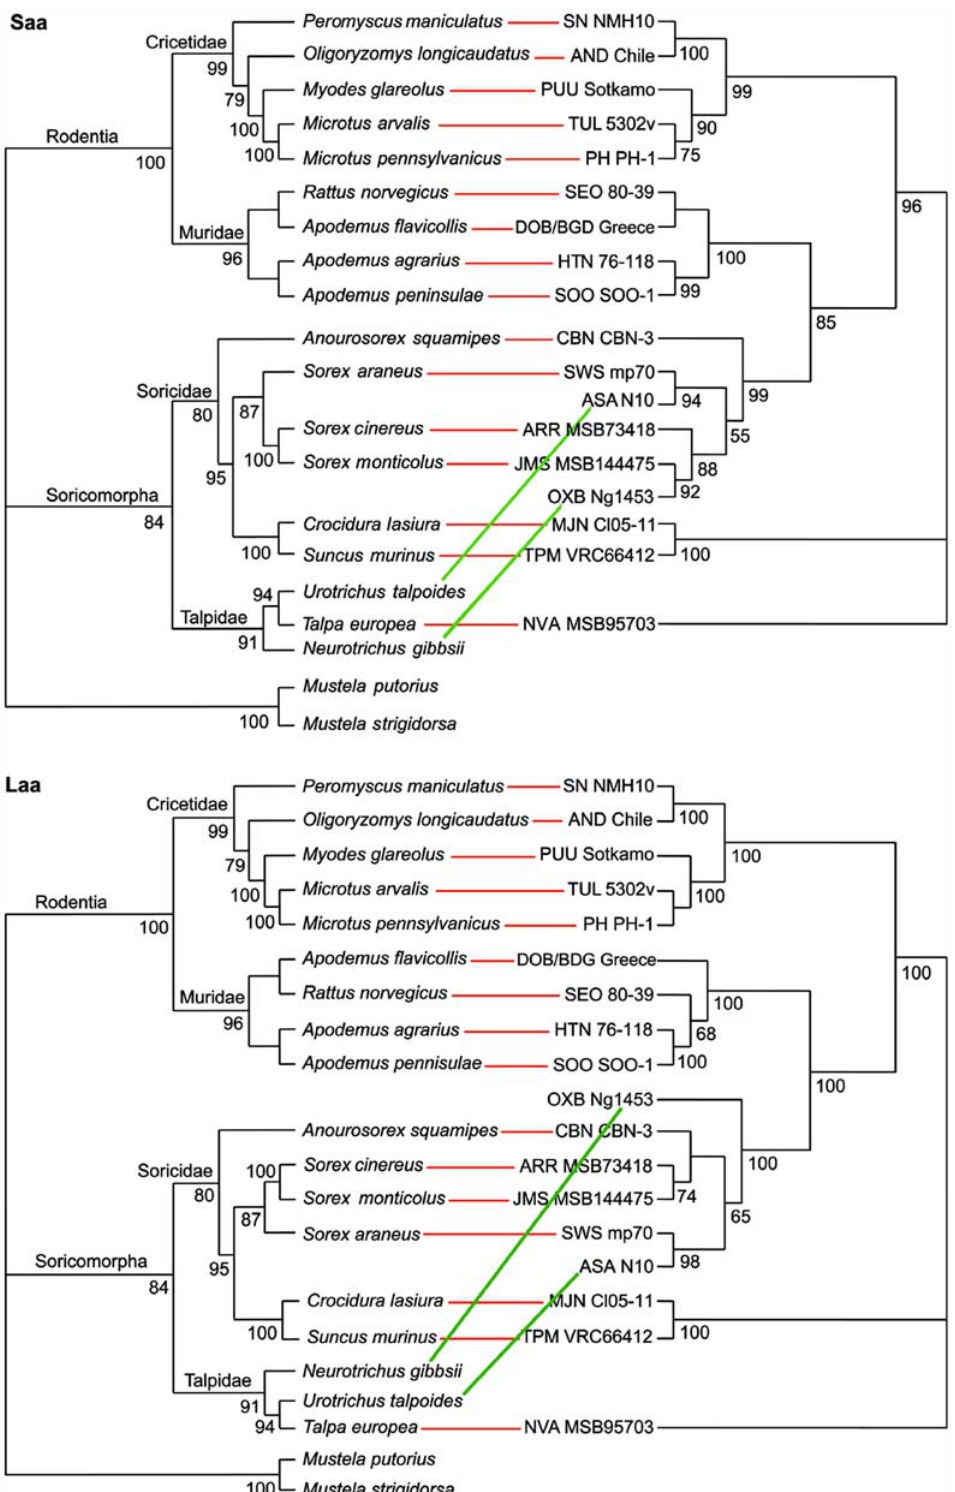
Figure 5. Tanglegrams, generated by TreeMap 2.0b, using consensus ML topologies based on the amino acid sequences of the nucleocapsid (N) protein (labeled Saa) and viral RNA-dependent RNA-polymerase (L protein) (labeled Laa) segments of NVA MSB95703 and representative rodent-, shrew- and mole-borne hantaviruses and cytochrome b mtDNA sequences of the respective reservoir host species. Node support was derived from 100 ML bootstrap replicates executed on the RAxML web server. Virus and host names are provided in the legend to Figure 4. Concordance of host and hantavirus cladograms was high (red line), except for two shrew mole-associated hantaviruses (ASA and OXB) which showed evidence of host switching (green line).